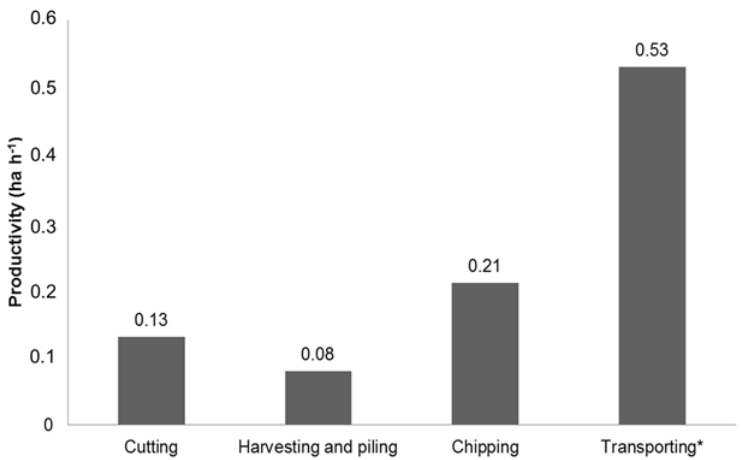
Figure 2. Productivity values obtained in the different working operations. * indicates value obtained with a 15 km transport distance.